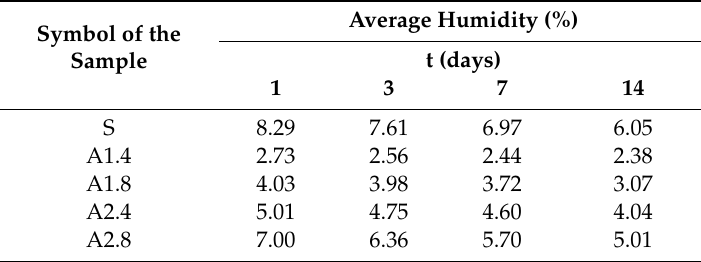
Table 5. The decrease in humidity (%).